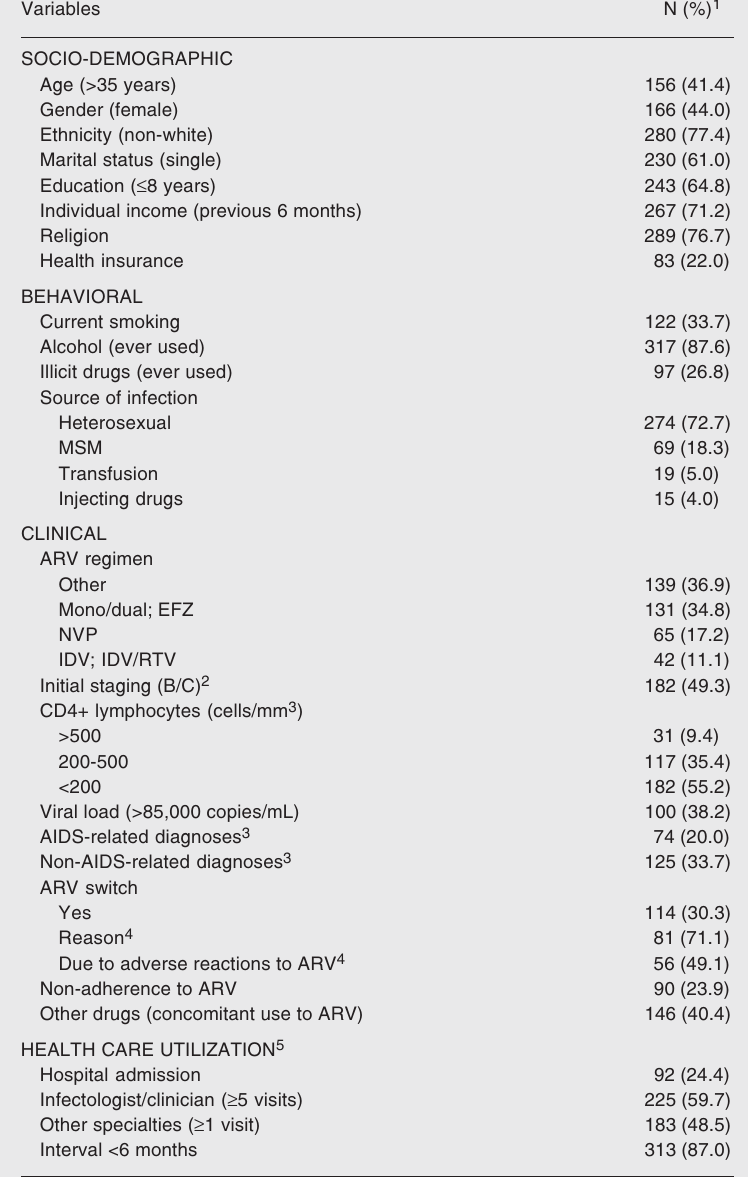
Table 2. Descriptive analysis of selected variables of the study population (N =